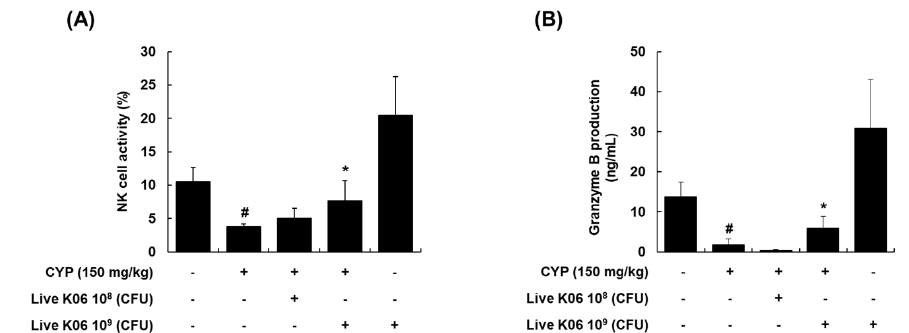
Figure 2. Effects of live K040706 on natural killer (NK) cell activity and granzyme B production in CYP-treated mice. Live K040706 (10 8 or 10 9 CFU/day) were orally administered for 20 days. ( A ) Splenocytes from different groups of mice were collected and treated with interleukin (IL)-2 for 72 h. After incubation, YAC-1 cells (target cells) were added to the IL-2-stimulated splenocytes at a ratio of 1:5 (effector-to-target) for 4 h. NK cell cytotoxic activity was measured with an lactate dehydrogenase (LDH) assay. ( B ) Granzyme B production in the cell culture supernatant of reacted YAC-1 cells + splenocytes was determined with ELISA. Data are presented as mean ± SD of 10 mice. # p < 0.05 vs. vehicle-treated control mice; * p < 0.05 vs. CYP-treated mice.